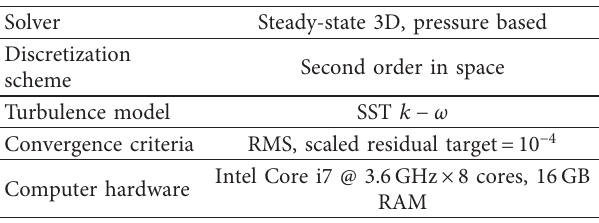
Figure 6: Mesh of flow domain (a coarser mesh shown for easy visualization; actual mesh used for simulation is denser than the mesh displayed). Table 1: Solver settings used for simulation.